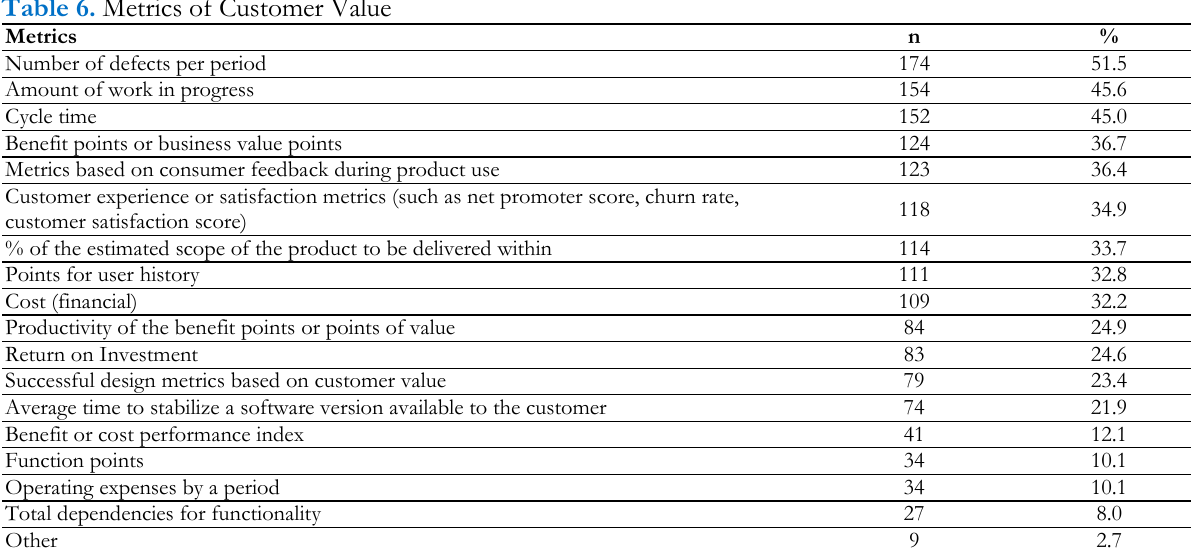
Table 6. Metrics of Customer